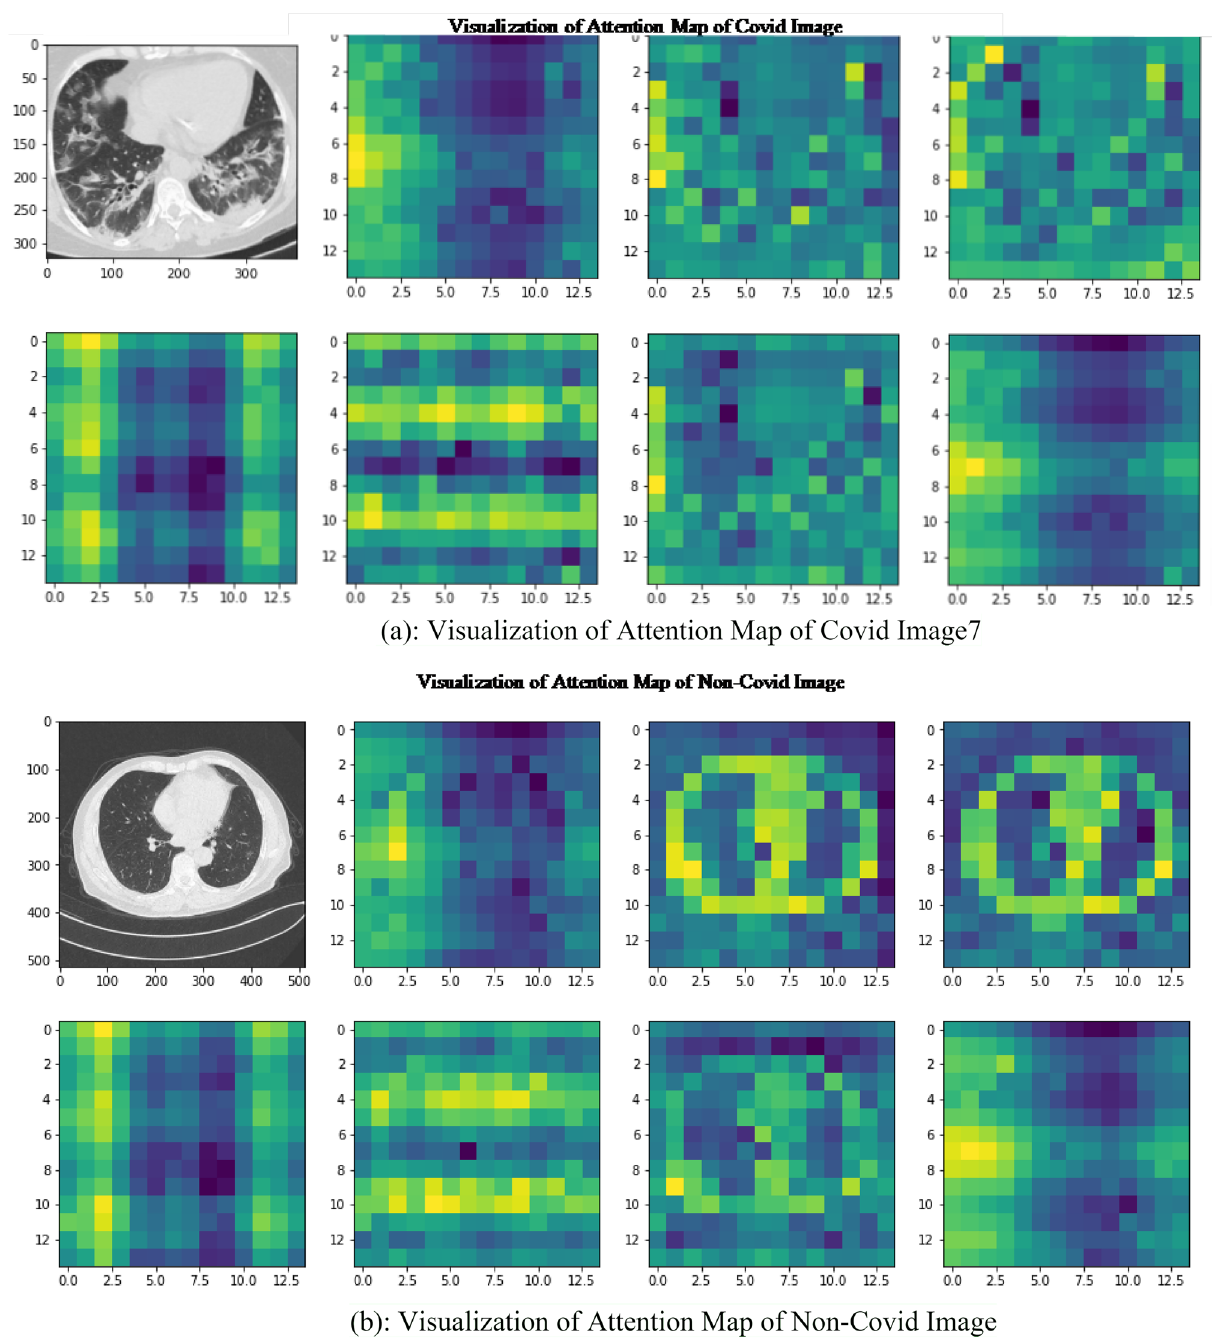
Figure 3. ( a ) Visualization of attention map of COVID Image7. ( b ) Visualization of attention map of non- COVID